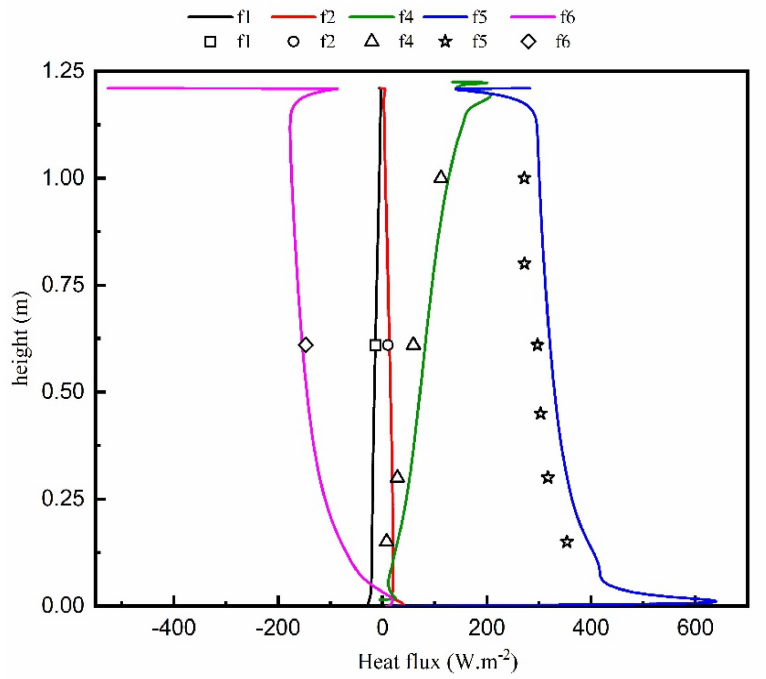
Figure 20. Experimental and numerical heat flux profiles for the three glazings, according to k-w models, P = 475 W.m − 2